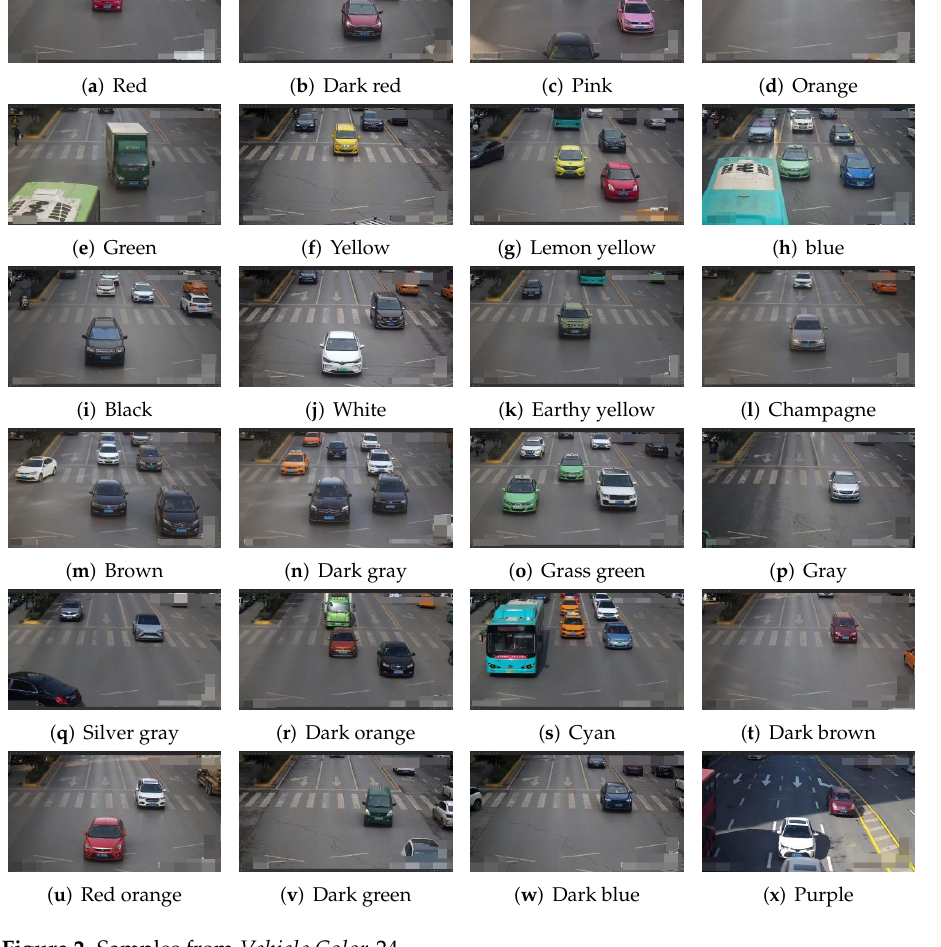
Figure 2. Samples from Vehicle Color